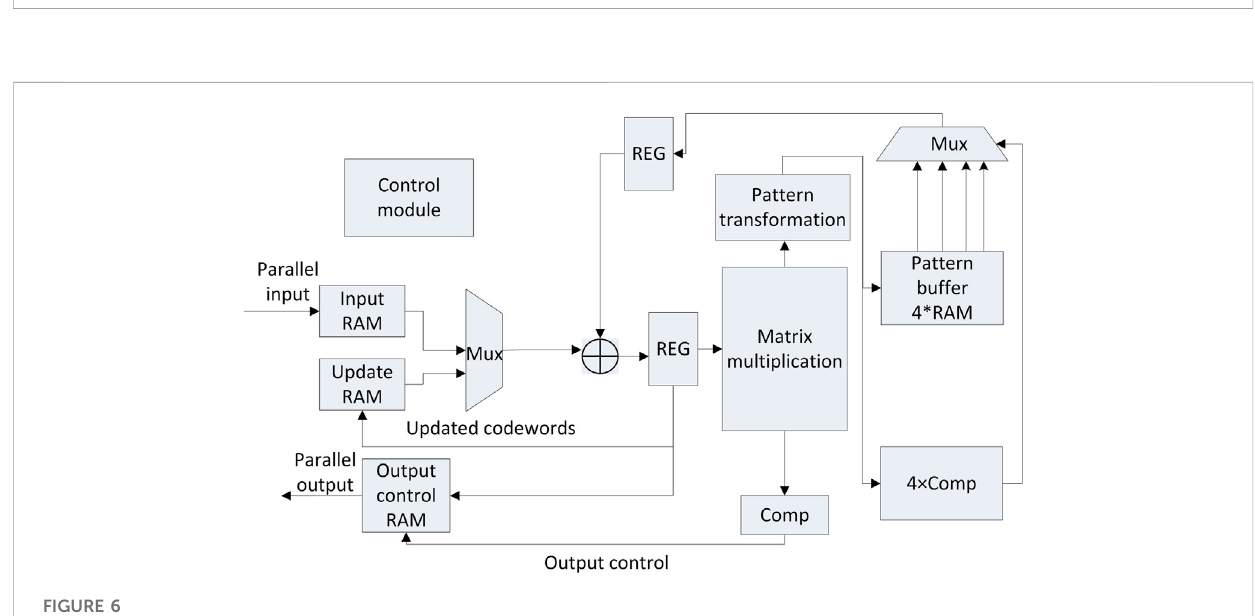
FIGURE 6 Structure of the parallel